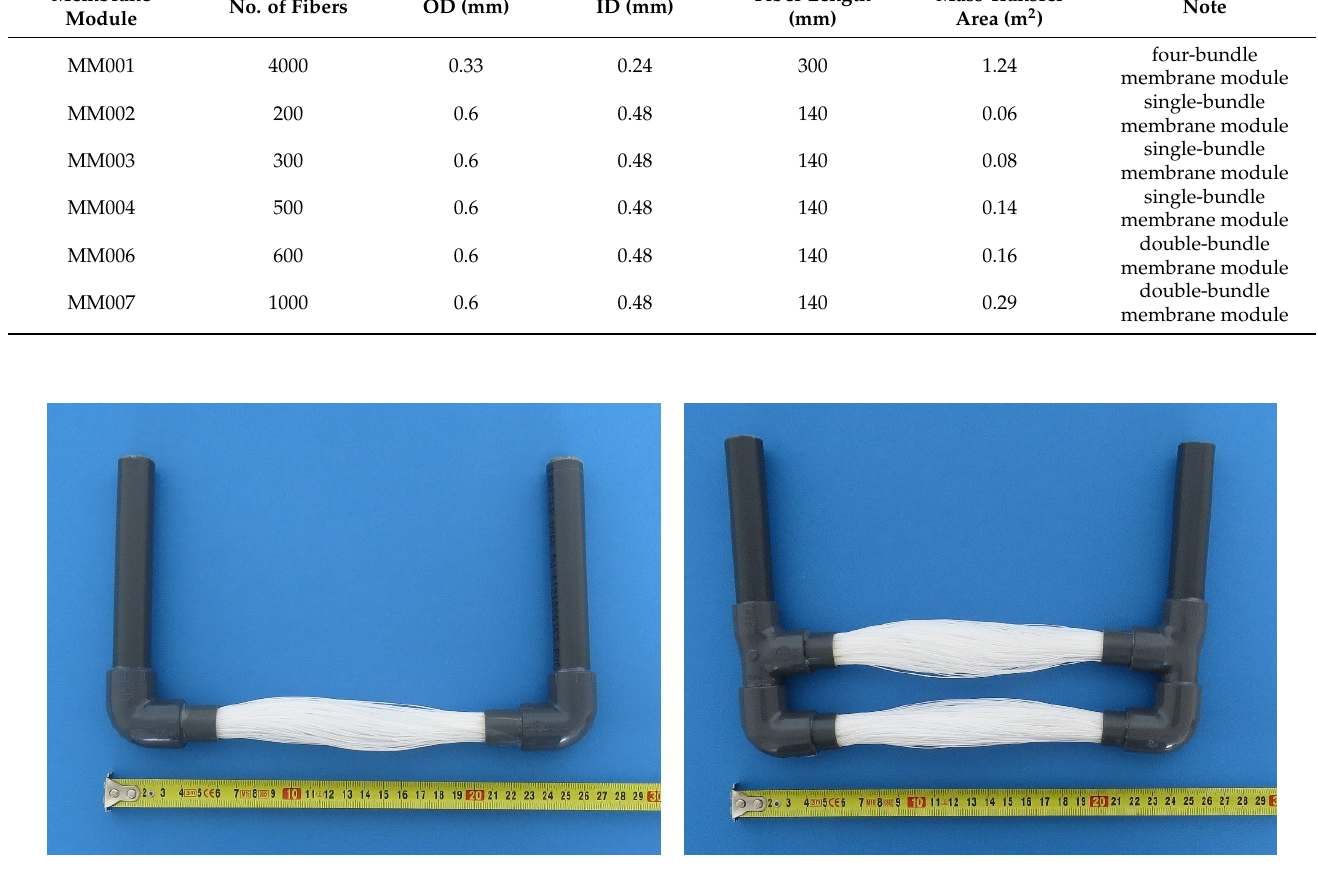
Figure 3. Single-bundle membrane module MM003 ( left ) and double-bundle membrane module MM006 ( right ).